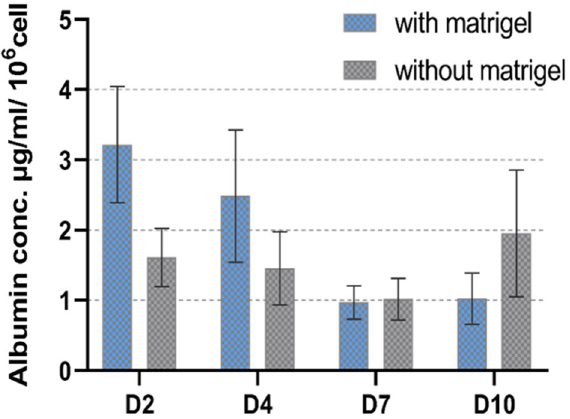
Figure 5. Functional analysis of embedded HepG2 in algMC with and without Matrigel-albumin secretion into cell culture supernatants after 2, 4, 7 and 10 days of cultivation, normalized to the cell number obtained by DNA quantification (n = 6; mean ± SD).